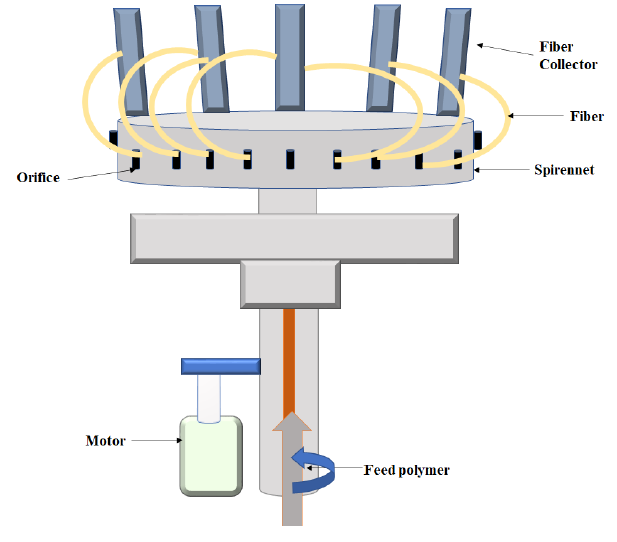
Figure 2. Schematic representation of centrifugal spinning. Table 1. Influence parameters in nanofiber characteristics in Forcespinning TM .